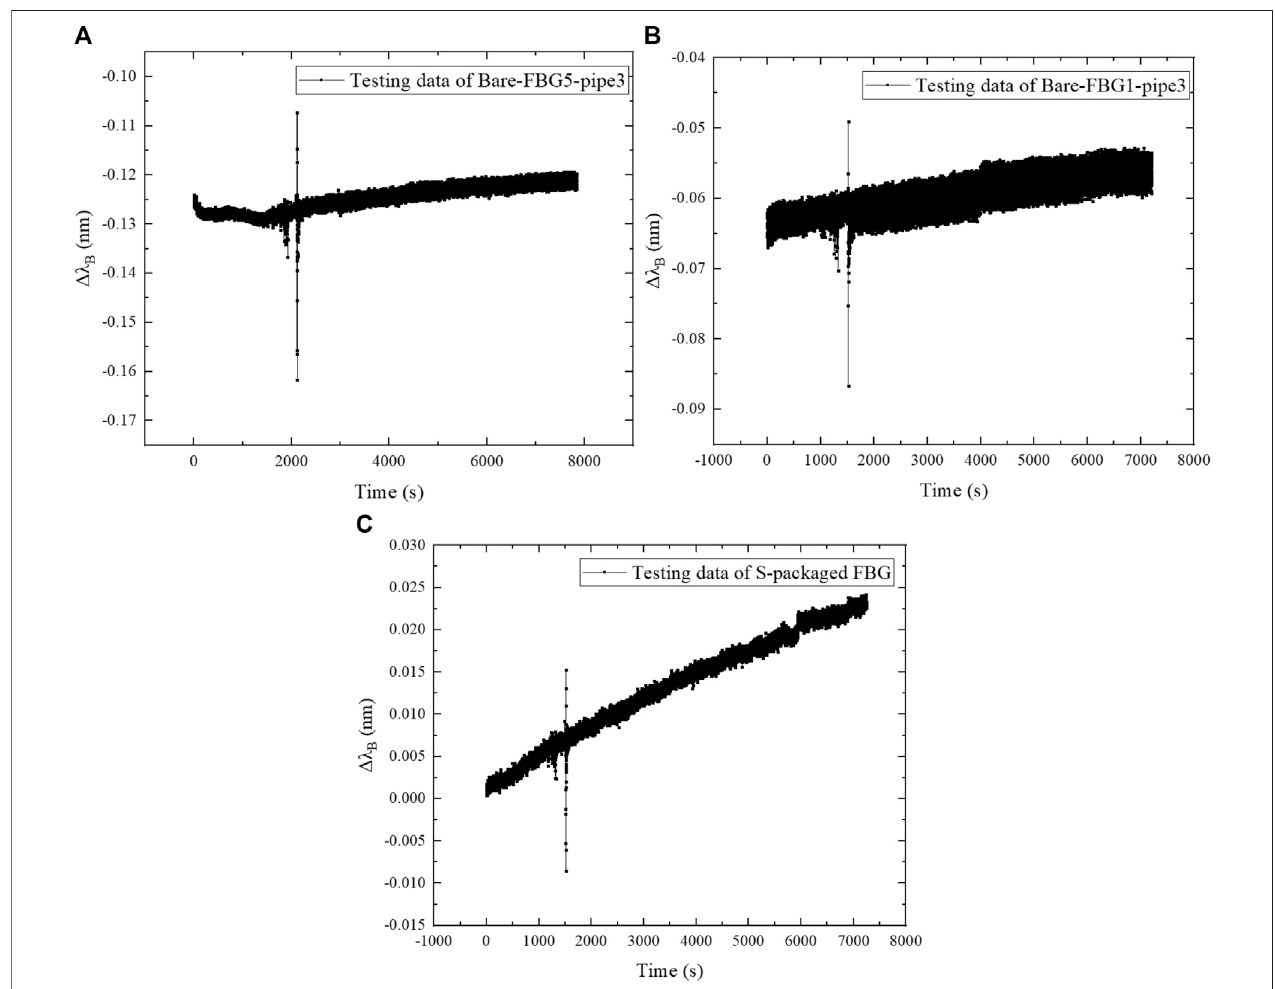
FIGURE 12 | Relationship of central wavelength increment with loading time at 50 Hz: (A) Bare-FBG5-pipe3; (B) Bare-FBG1-pipe3; (C) S-packaged FBG.